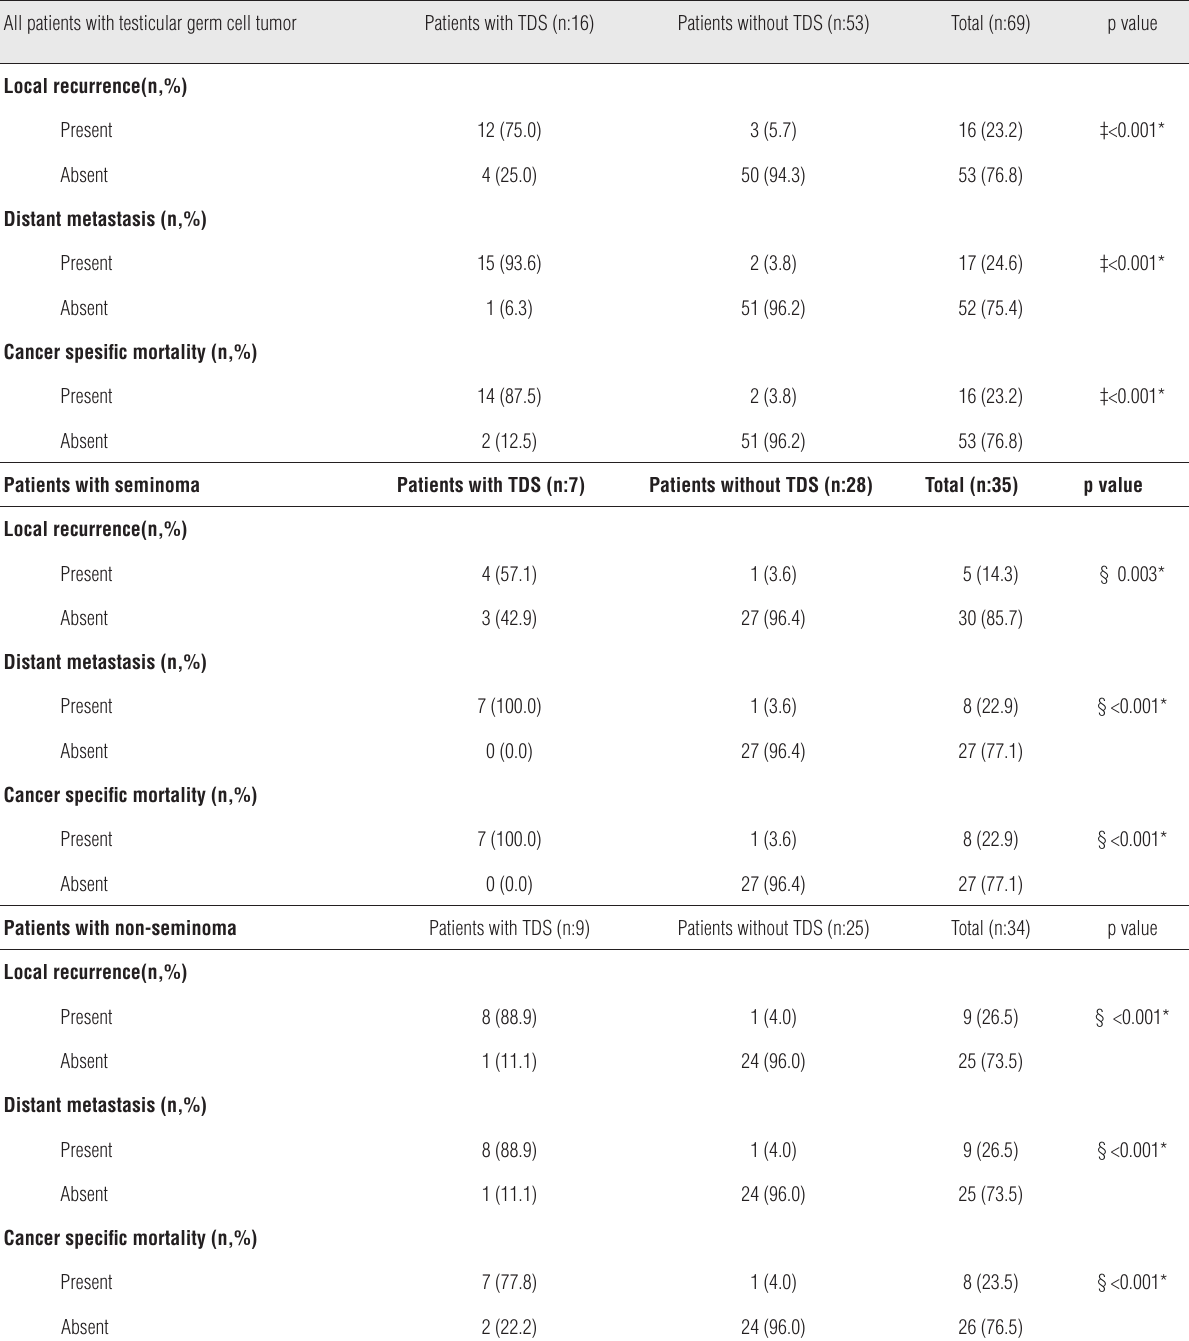
Table 3 - Oncologic outcomes of the patients in terms of testicular dysgenesis syndrome. All patients with testicular germ cell tumor Patients with TDS (n:16) Patients without TDS